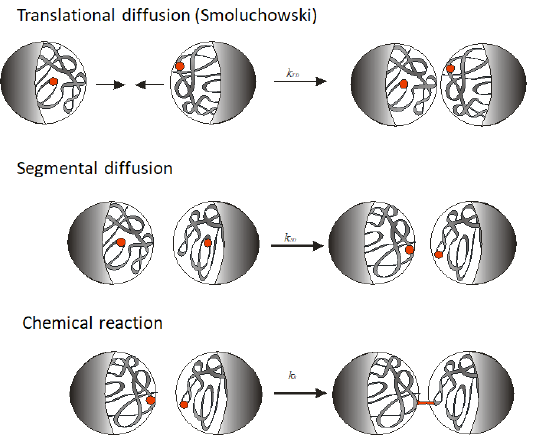
Figure 8. Schematic interpretation of intermolecular recombination steps: translational diffusion of the coils, segmental diffusion, and chemical reaction (crosslinking) of polymer radicals. Based on the Smoluchowski equation for the second-order rate constant of a reaction between two identical spherical reagents controlled by translational diffusion (Equation (8), [14,99,100]), where R is the reaction radius of a sphere and D is its diffusion coefficient, we can estimate the expected rate constant for such process in our case.